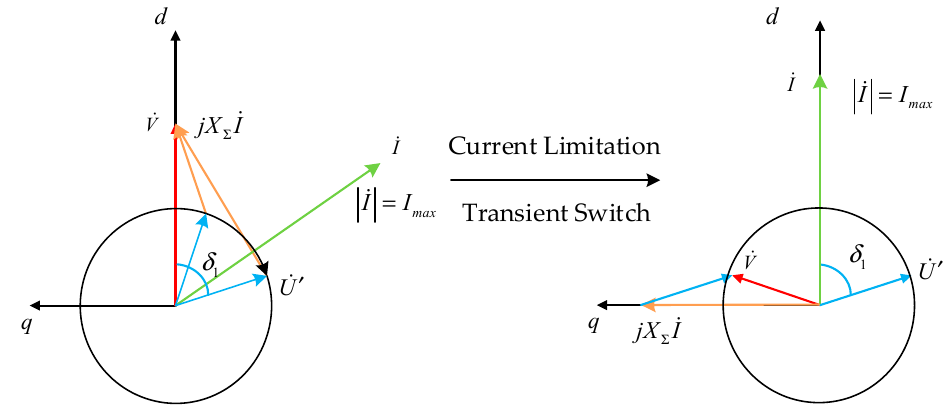
Figure 10. Vector diagram of transient switching process of voltage source and current source.